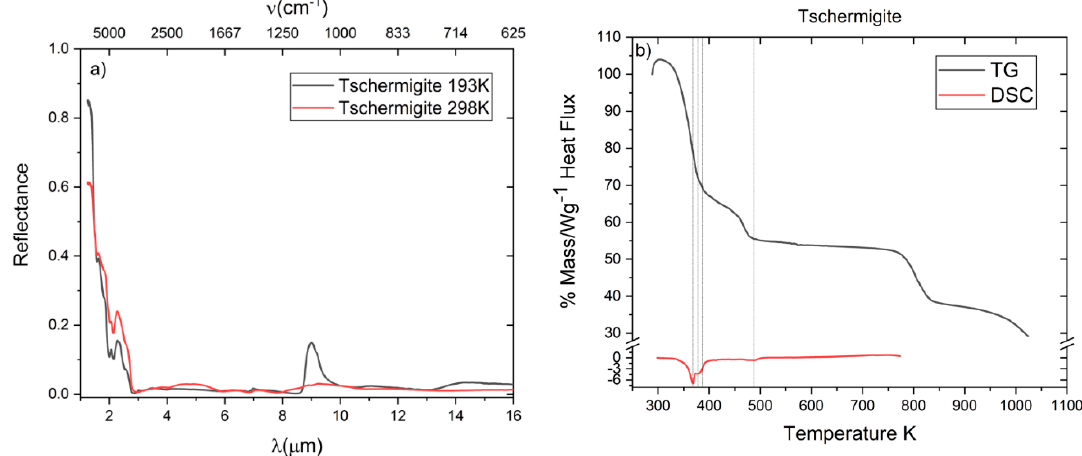
Figure 6. Reflectance spectra at room temperature and 193 K ( a ) and TG / DSC ( b ) analysis from room temperature to 773 and 1023 K of tschermigite.